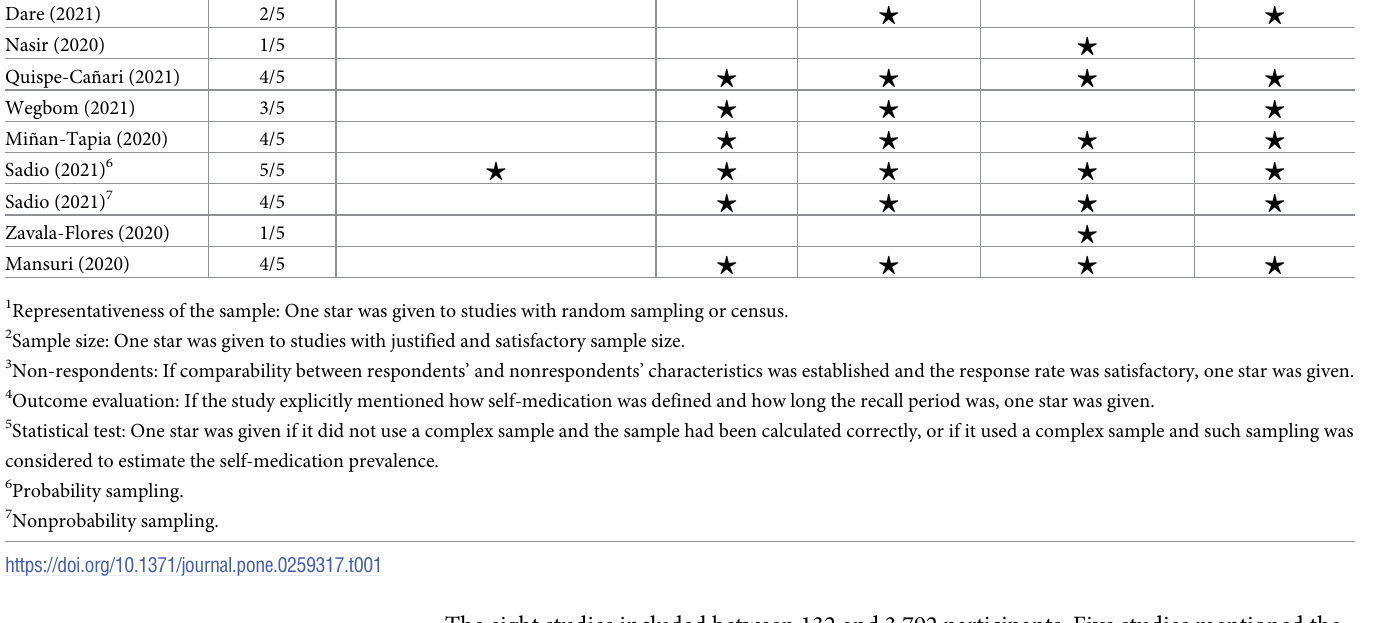
Table 1. Risk of bias assessment of included studies using the Newcastle–Ottawa Scale adapted for cross-sectional studies. Study:Author